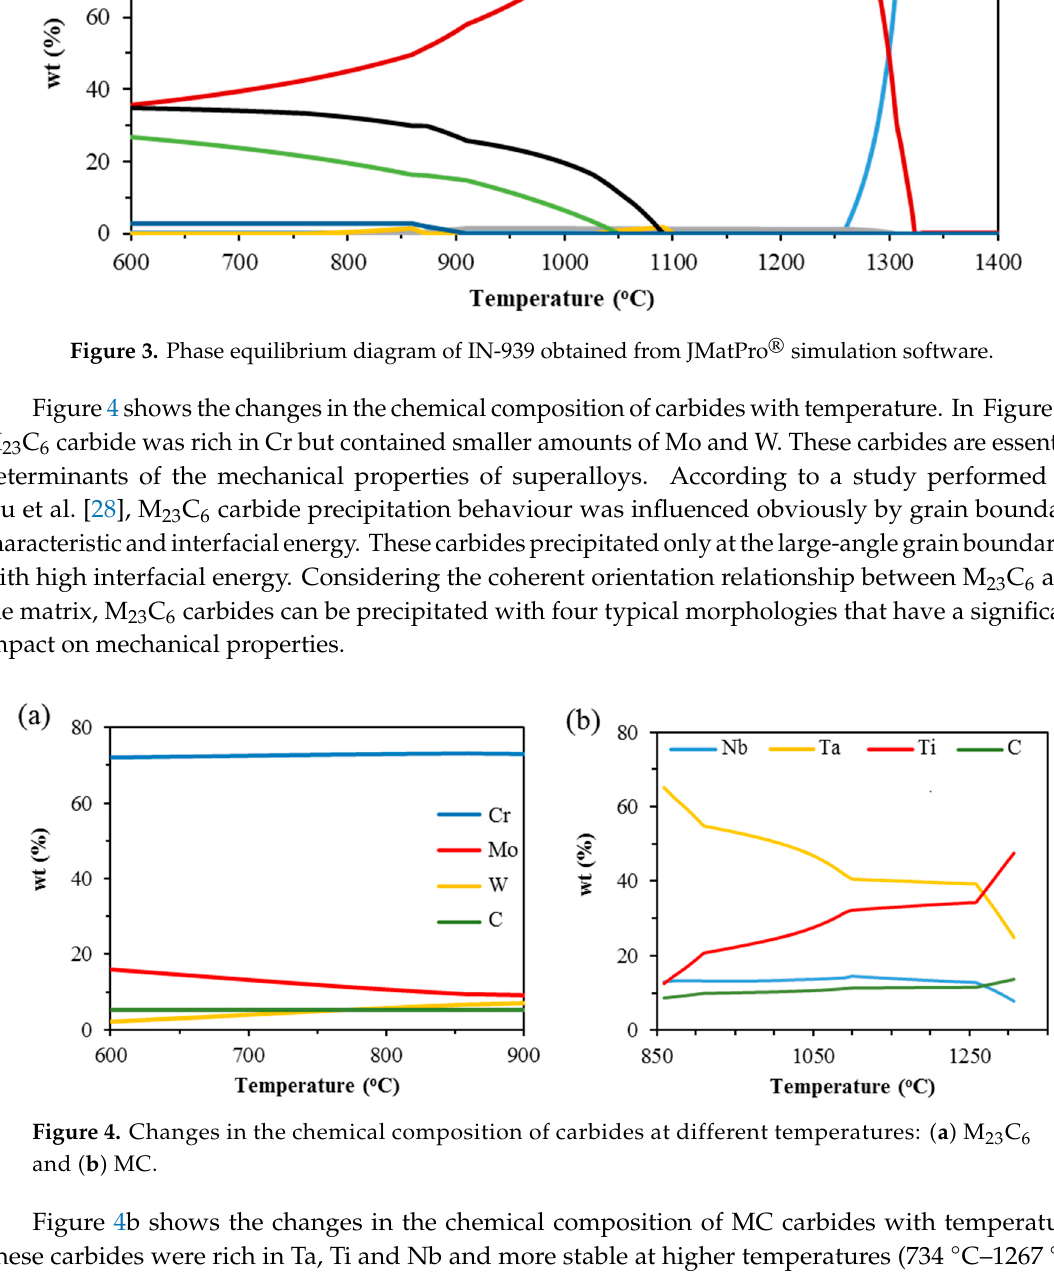
Figure 4. Changes in the chemical composition of carbides at different temperatures: ( a ) M 23 C 6 and ( b ) MC.